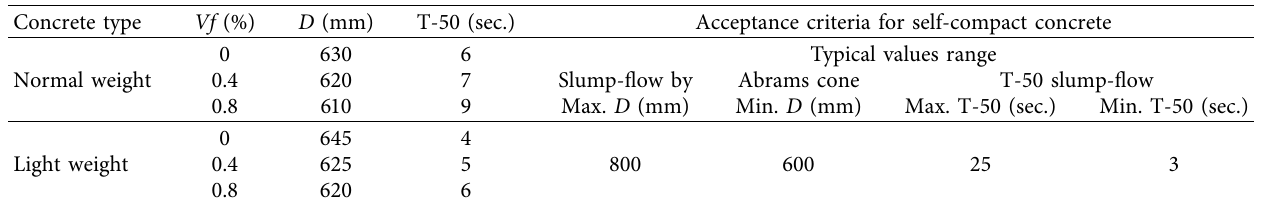
Figure 3: Setup on which slab specimens are tested. Table 7: Slump-flow test and acceptance criteria for self-compact concrete.